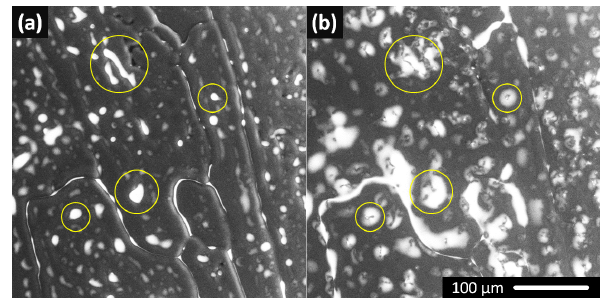
Figure 5. The ESEM images of the seeded sample prepared from the 0.05MCsCl solution at the very beginning of the observation (a) and after 90s (b) . The images were recorded at the temperature of − 25 ◦ C. As conditions below the sublimation curve had been set inside the specimen chamber, sublimation of the top layer of the ice was presumed during the time interval between two images. It is clearly visible that the humps formed at spots previously covered with the brine; four examples of such spots are